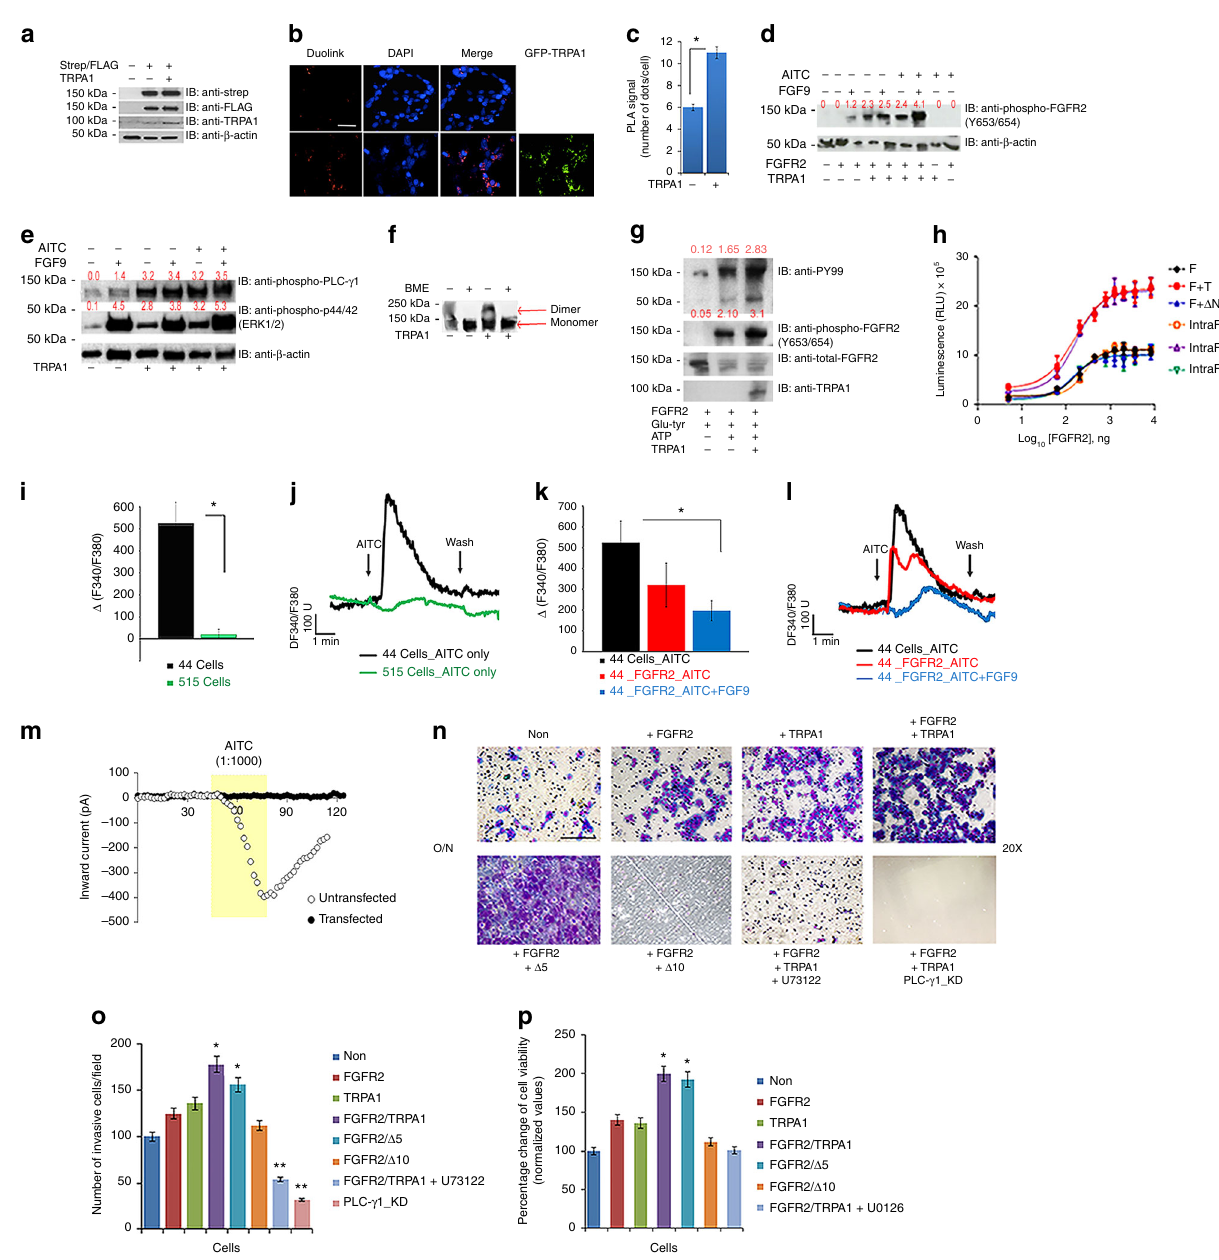
Fig. 3 FGFR2-TRPA1 binding event results in FGFR2 activation, but TRPA1 inhibition. a Western blot showing the ef fi ciency of transfection of Strep-tagged FGFR2, FLAG-tagged FGFR2, and TRPA1-GFP in HEK 293T cells. b , c Duolink assay in HEK 293T cells using antibodies targeted against Strep-tagged and FLAG-tagged FGFR2 in the absence (upper panel) or presence (bottom panel) of TRPA1. Scale bar: 50 μ m. PLA signals are quanti fi ed in ( c ). d Western blot analysis of differentially transfected and treated HEK 293T cells. The blot was probed with the indicated antibodies. e Western blot analysis of HEK 293T cells transfected with FGFR2 in all samples but differentially transfected with TRPA1. The blot was probed with the indicated antibodies. f Western blot analysis of puri fi ed FGFR2 dimerization assay (under non-reducing or reducing conditions) in the presence or absence of puri fi ed TRPA1. g Western blot analysis of an in vitro receptor kinase assay in the presence or absence of puri fi ed TRPA1. h Luminescent kinase assay results of puri fi ed full length FGFR2 (F) and intracellular cytoplasmic region of FGFR2 (IntraF) in the presence or absence of full-length TRPA1 (T) or Δ N. Intensity of the luminescence signal is measured in relative luminescence units (RLU). i – k Bar graphs of the averaged calcium imaging results ( Δ F340/380) with representative traces of calcium responses. m Example inward currents, from a holding potential of − 60 mV, evoked in untransfected ( ○ ) and FGFR2-transfected HCC-44 cells ( ● ) by the application of AITC (1:1000 in the perfusate). Currents were recorded at 2 s intervals for a control period, during application of AITC and then during washout. n Representative images of an invasion assay using differentially transfected HEK 293T that were incubated over night (O/N) in serum starvation media. Lower chamber contains 1% FBS-supplemented media. Images were taken at 20× magni fi cation (scale bar: 100 μ m). U73122 is PLC- γ 1 inhibitor and PLC- γ 1_KD designates HEK 293T cell line with knocked down PLC- γ 1. o Quanti fi cation of the results from ( n ), where the number of invaded